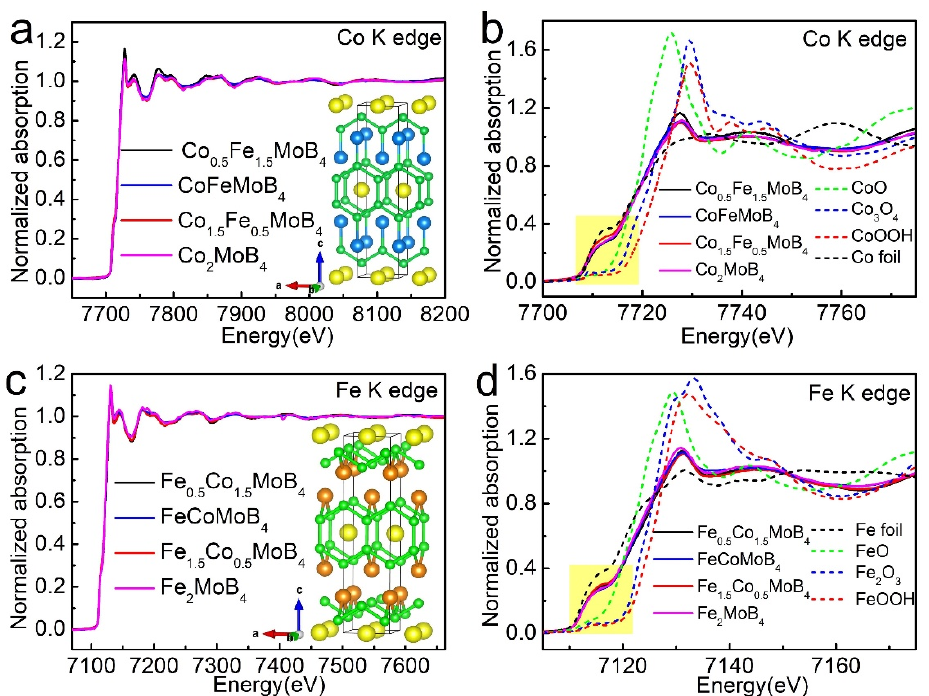
Figure 2. ( a , c ) are normalized full XAFS spectra of the Co and Fe K edge of different samples; the insets are structures of Co 2 MoB 4 and Fe 2 MoB 4 (Yellow spheres are Mo atoms, green spheres are B atoms, blue spheres are Co atoms and orange spheres are Fe atoms); ( b , d ) are normalized XANES of Co and Fe K edge spectra of different samples and some related metal oxides/oxyhydroxides.